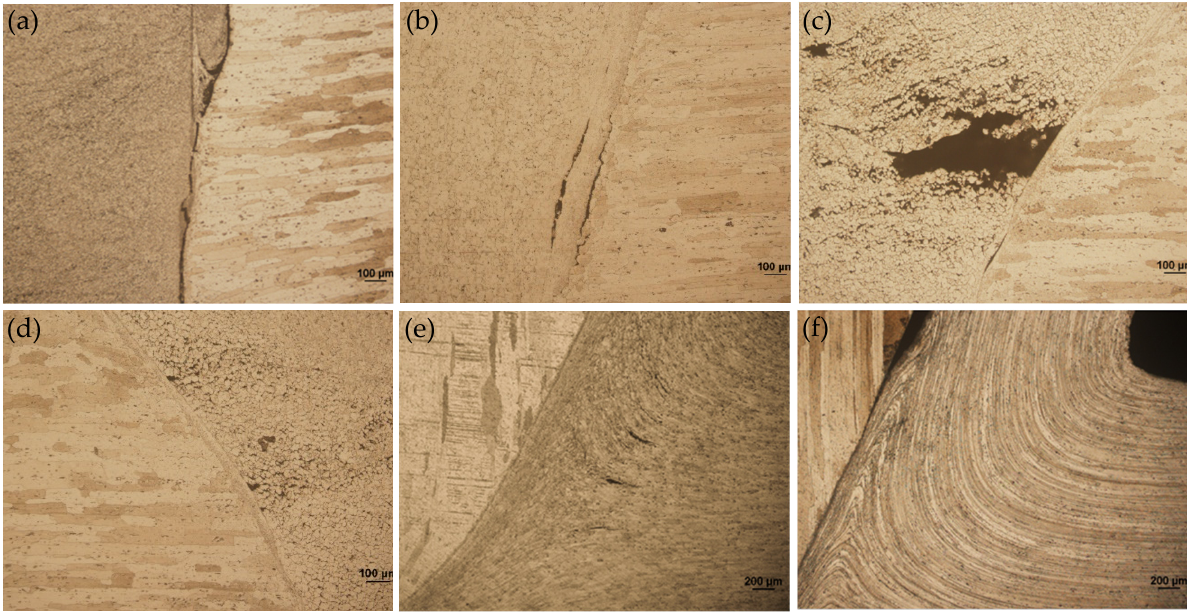
Figure 6. Welding defect morphology of regions marked in Figure 5: ( a ) region a, ( b ) region b, ( c ) region c, ( d ) region d ( e ) region e and ( f ) region f.